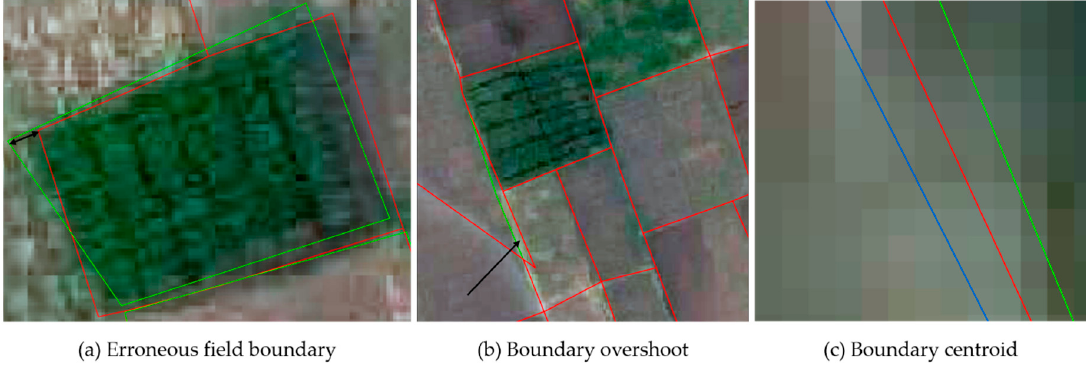
Figure 4. Major phases of processing to bring individual field boundaries into one master dataset (REF in red), which included averaging individual digitizers after elimination of erroneous field boundaries and gaps / slivers in green in ( a ) and ( b ). The green and blue lines in ( c ) represent boundaries defined by individual digitizers. Imagery © 2011 DigitalGlobe, Inc.